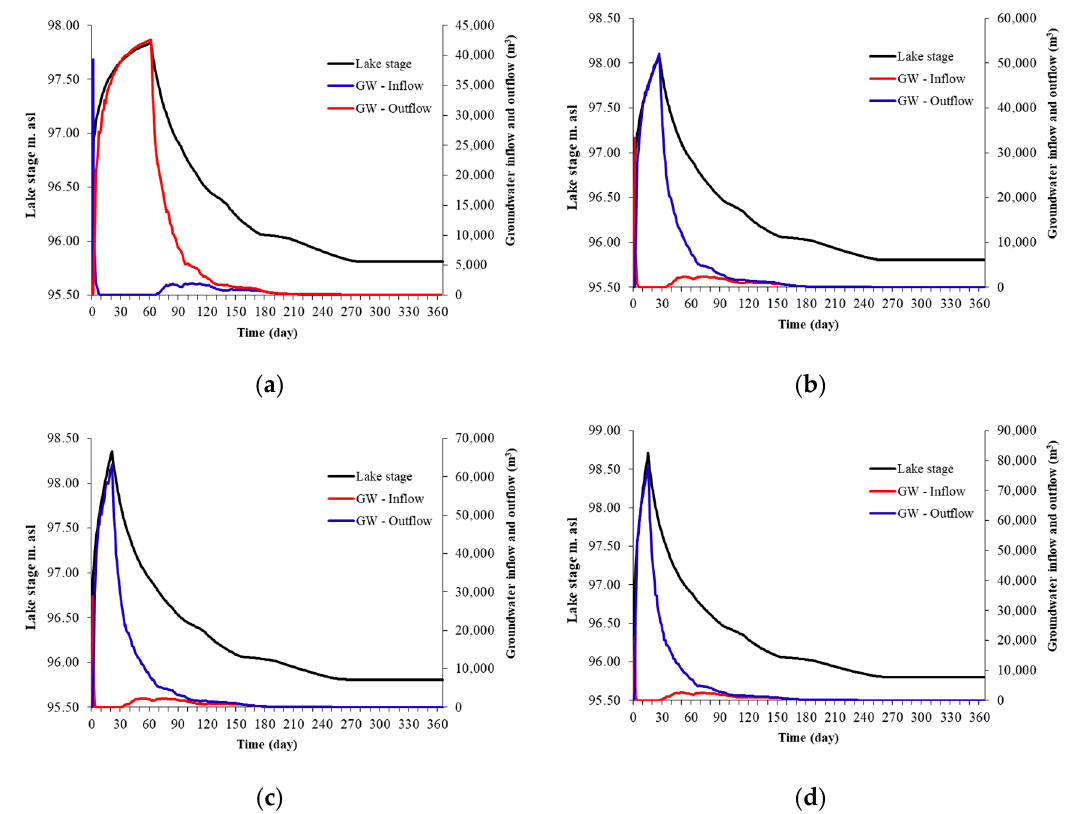
Figure 9. Daily variability of Okor lake stage, groundwater seepage into the lake (GW-Inflow), seepage from the lake into groundwater (GW-Outflow), and net lake seepage (LLKnet) during simulation period of one year. Note that the fluxes are referenced to the temporally variable lake with different feeding discharges. ( a ) Feeding by Q = 0.5 m 3 s − 1 , ( b ) Q = 0.75 m 3 s − 1 , ( c ) Q = 1.0 m 3 s − 1 and ( d ) Q = 1.5 m 3 s − 1 .